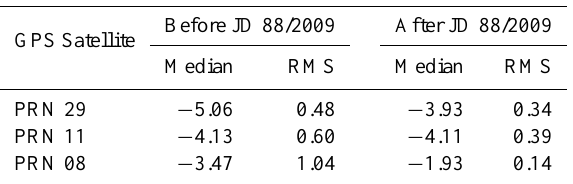
Table 3. Values of ionospheric delay in AQUI, expressed in meters.